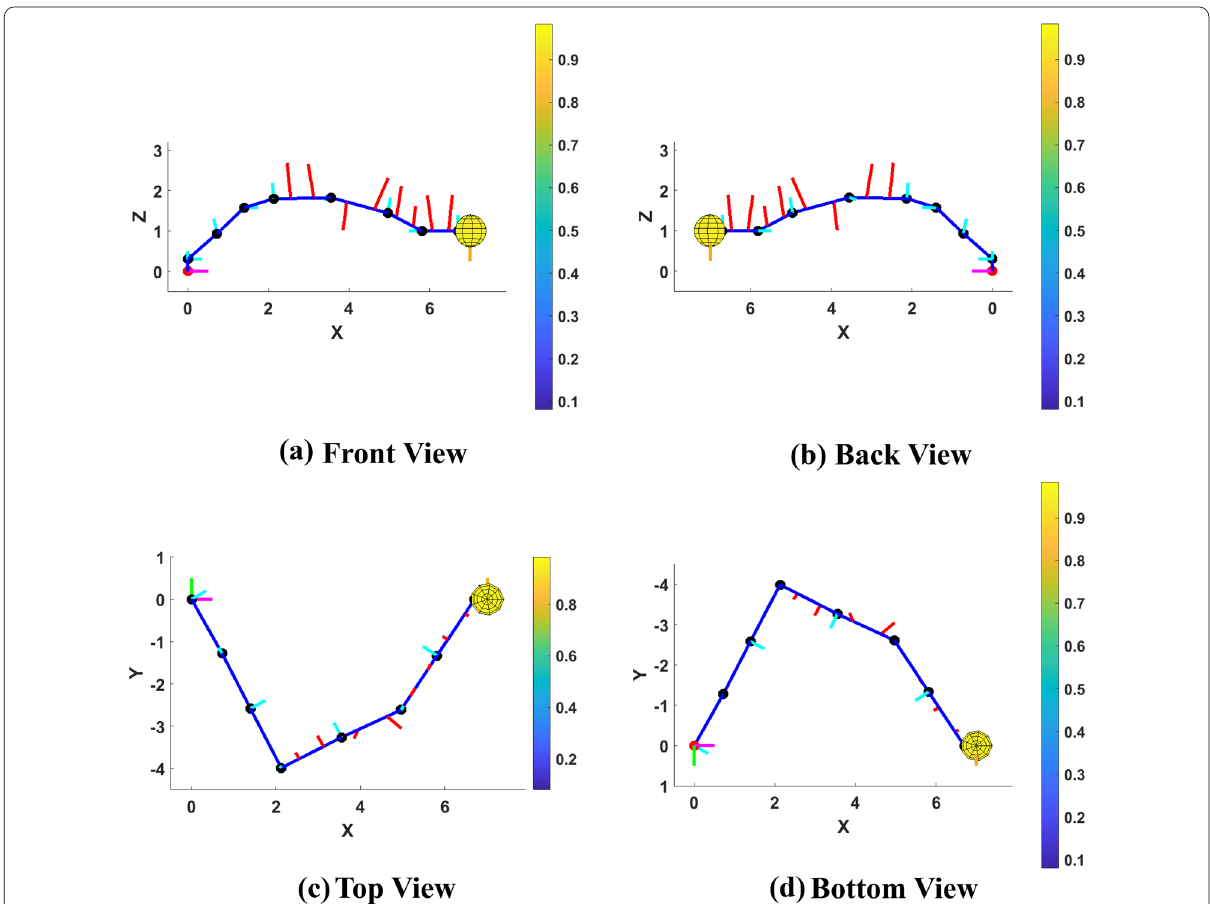
Fig. 12 The front, back, top, and bottom views of the AOWS-based flying watch allocation, end effector reaction force, and the corresponding average TDS in the object manipulation mission. a Front view. b Back view. c Top view. d Bottom